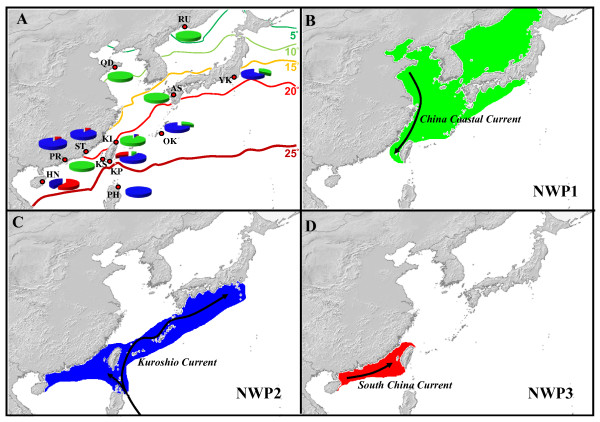
The distribution of three cryptic species of Mugil cephalus in the northwestern Pacific. (A) the proportions of the three species in various locations; coloured lines indicate sea surface temperature in the NW Pacific in December, which is the period of reproductive migration of Mugil cephalus; (B) the distribution range of NWP1 and location of the China Coastal Current; (C) the distribution range of NWP2 and location of the Kuroshio Current; (D) the distribution range of NWP3 and location of the South China Sea Current.